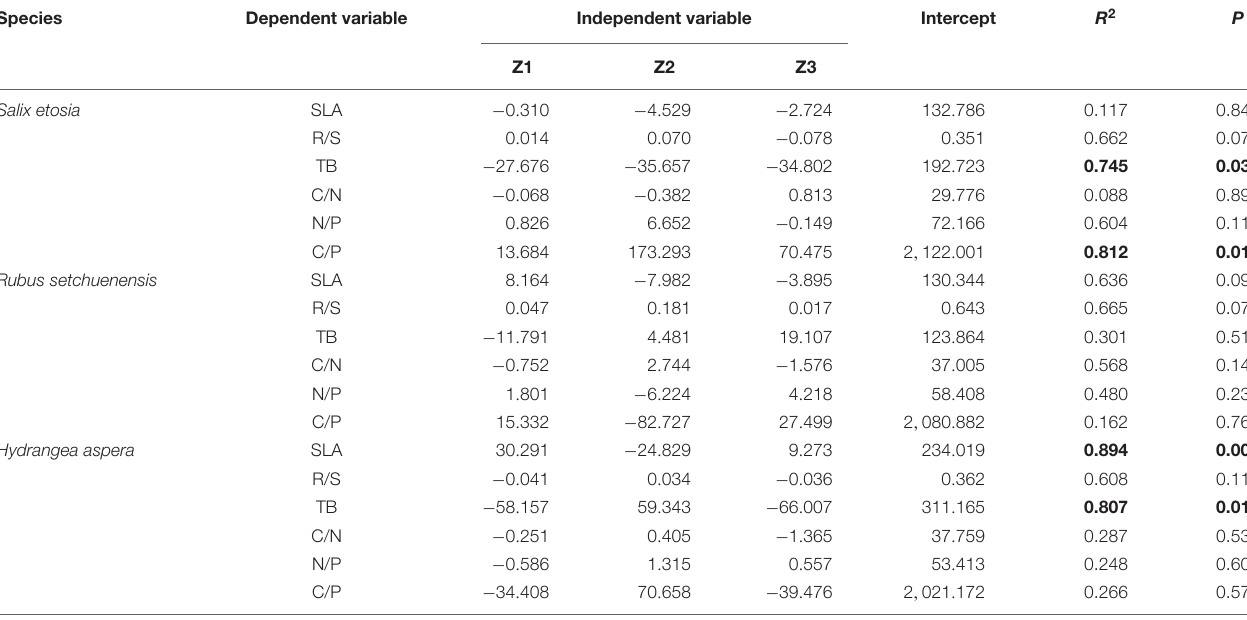
TABLE 4 | Regression analysis of leaf traits and biomass production with principal components. Species